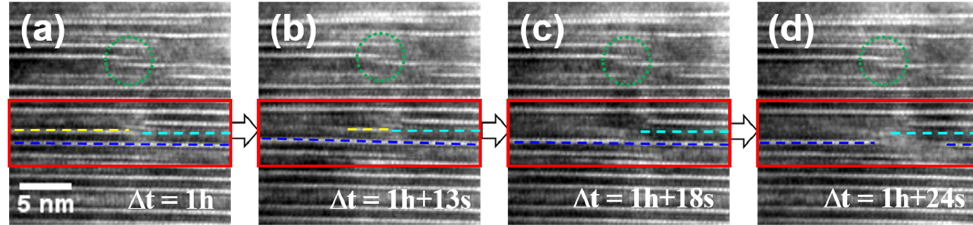
Figure 6. Sequential TEM images showing the inter-growth of faulted regions across conduction layers.